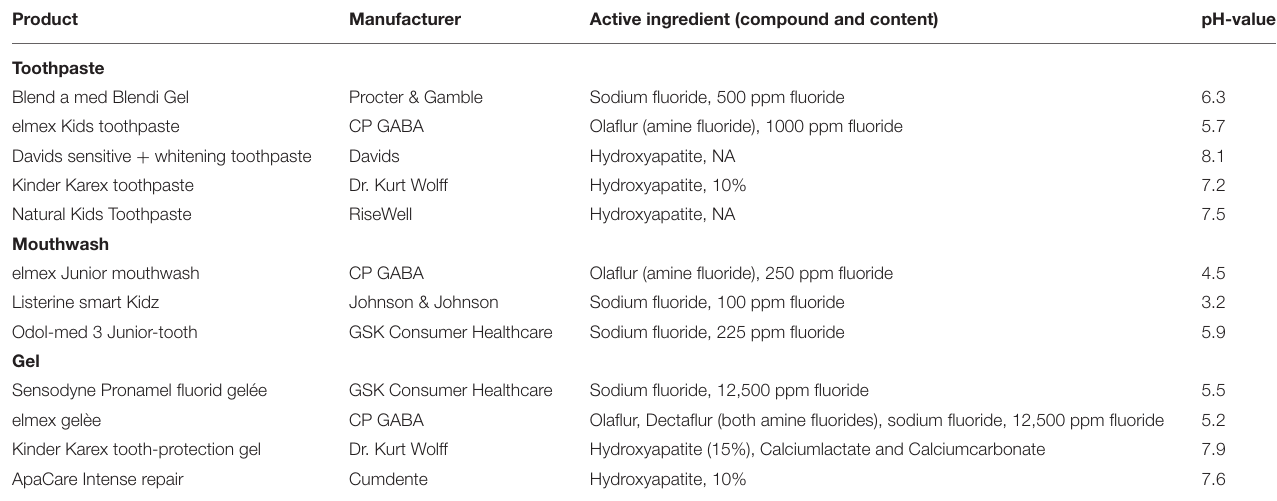
TABLE 1 | pH-values of commercially available toothpastes, mouthwashes, and gels for